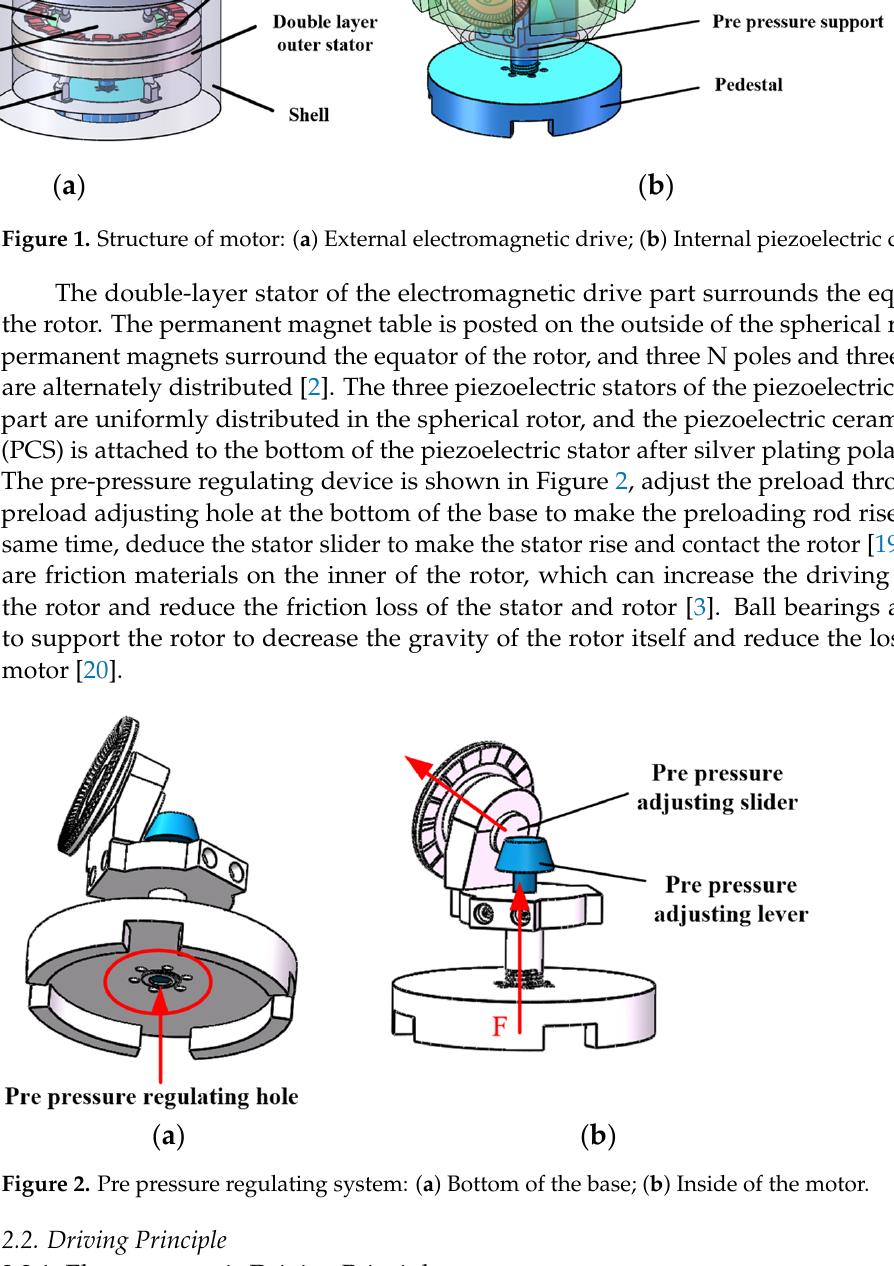
Figure 2. Pre pressure regulating system: ( a ) Bottom of the base; ( b ) Inside of the motor.